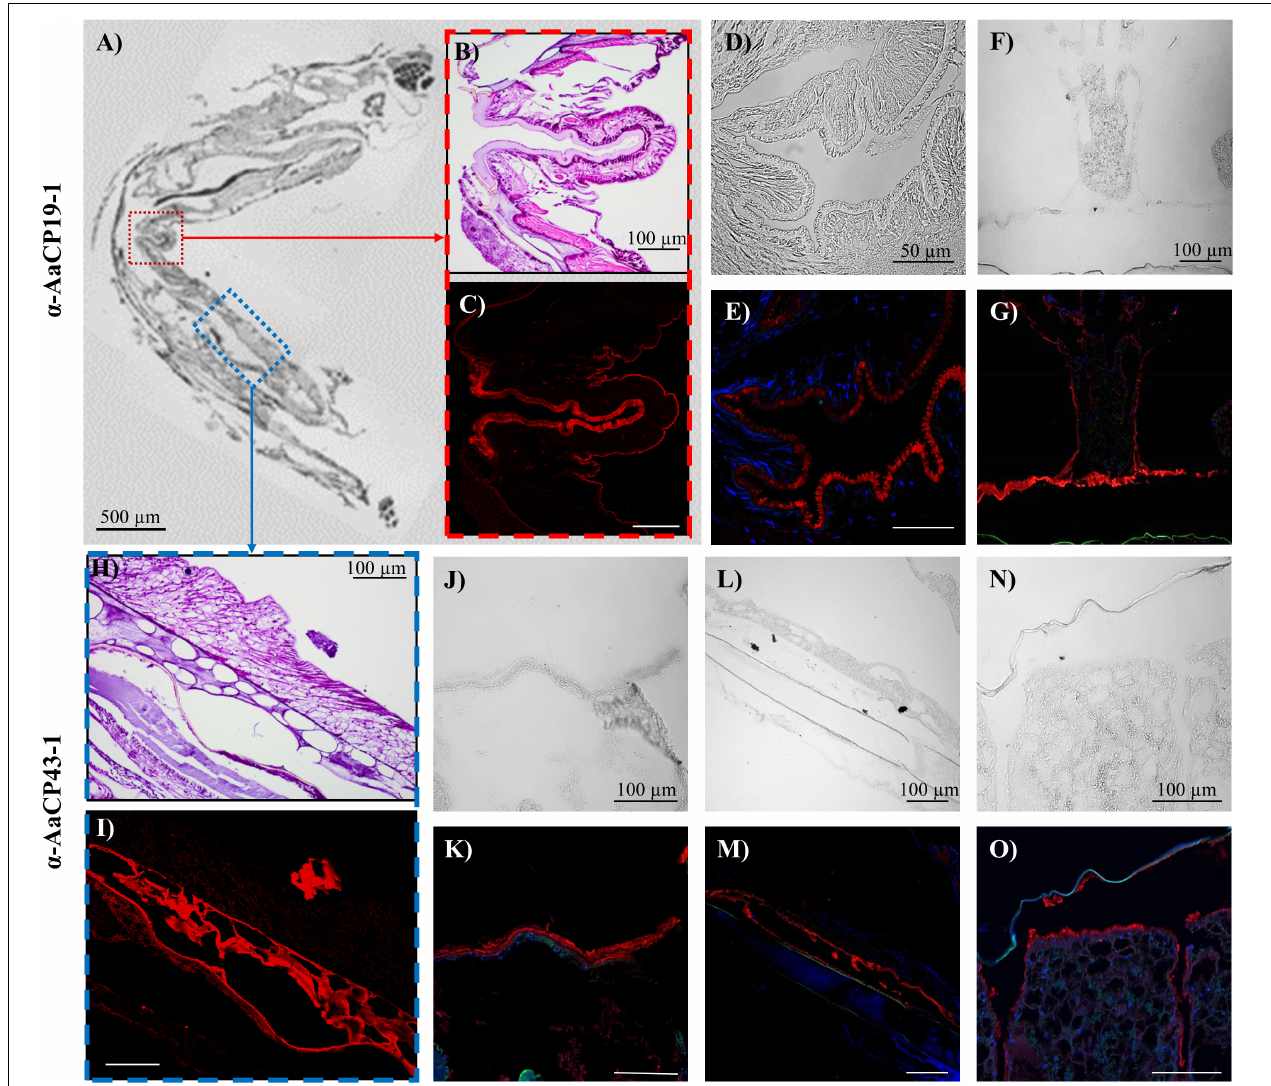
FIGURE 4 | Immunohistochemistry results for (A–G) α -CP19-1 and (H–O) α -AaCP43-1 from sections ∼ 130 µ m from the substrate interface. (A) Brightfield image of transverse FFPE section containing tissue lining the inside of the shell above the sub-mantle tissue. (B) H&E stained and (C) Cy5 channel from α -AaCP19-1 stained section represented by the red box in panel (A) . (D,F) Brightfield and (E,G) fluorescent (DAPI and Cy5 channels) images of other transverse sections showing positive α -CP19-1 staining of the lining tissue near the operculum. (H) H&E stained and (I) Cy5 channel from α -AaCP43-1 stained section represented by the blue box in panel (A) . (J,L,N) Brightfield and (K,M,O) corresponding fluorescent images of α -AaCP43-1-labeled transverse sections. (J–M) α -AaCP43-1 stained tissue linings in proximity to the parietal shells. (N,O) Lining of longitudinal canal tissue staining positive for α